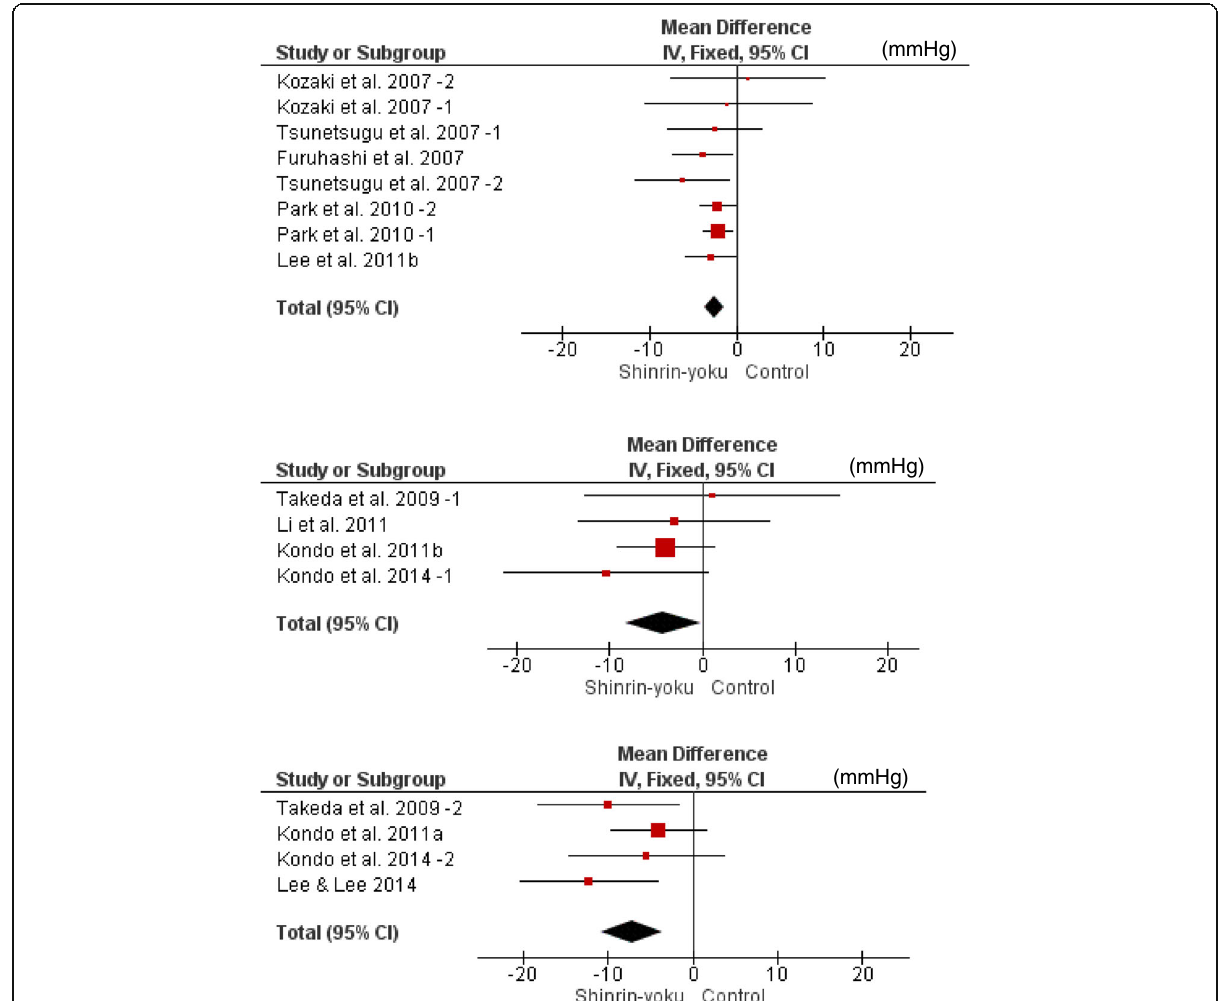
Fig. 5 Three forest plots of the change in SBP (mmHg) in the two subgroup analyses of the three groups of sex and age differences. 1) Young male (university student) group. 2) Middle-aged or older male group. 3) Middle-aged or older female group. CI, confidence